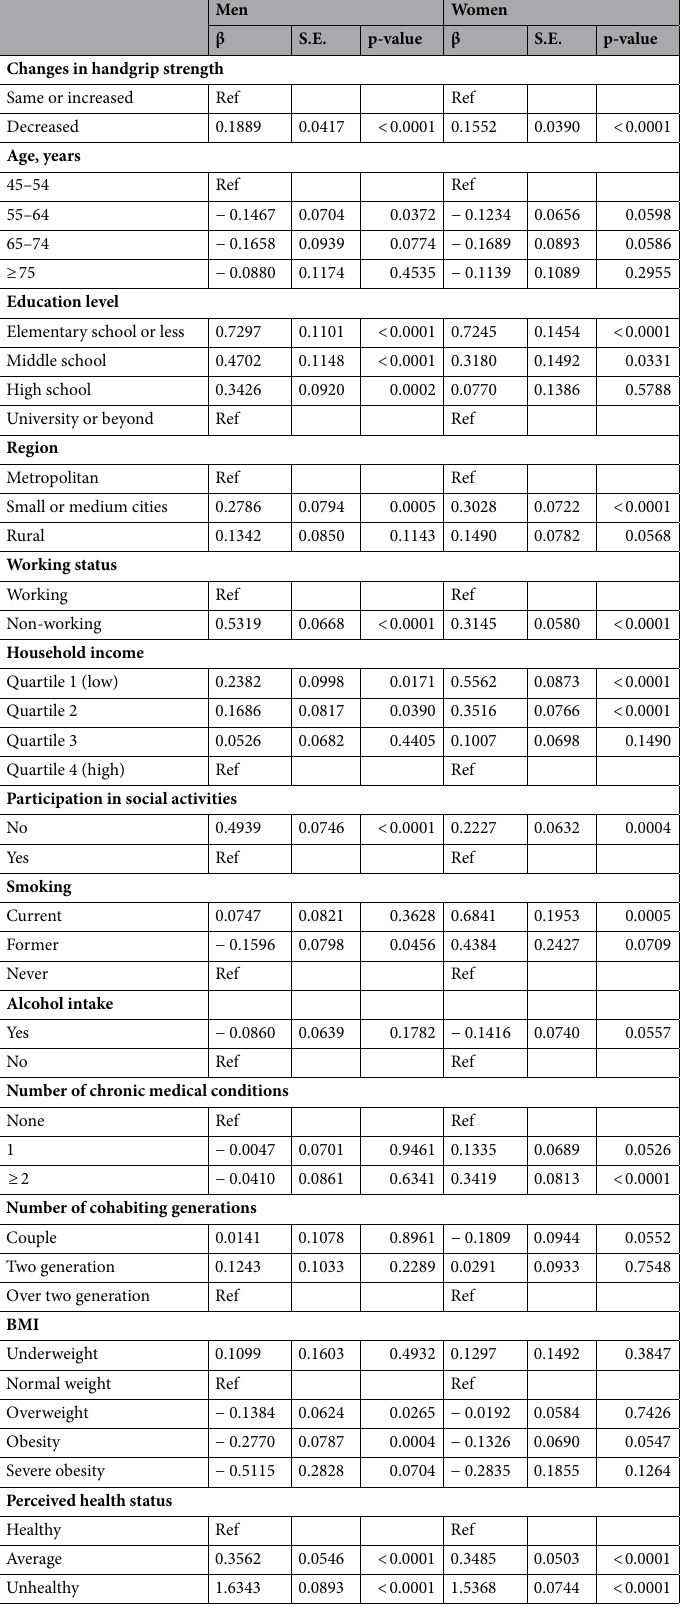
Table 2. Results of the generalized estimating equation analysis of handgrip strength change in the two groups and short-form Center for Epidemiologic Studies Depression Scale scores. Underweight: BMI < 18.5; normal weight: 18.5 ≤ BMI < 23; overweight: 23 ≤ BMI < 25; obesity: 25 ≤ BMI < 30; severe obesity: 30 ≤ BMI. BMI body mass index, S.E. standard